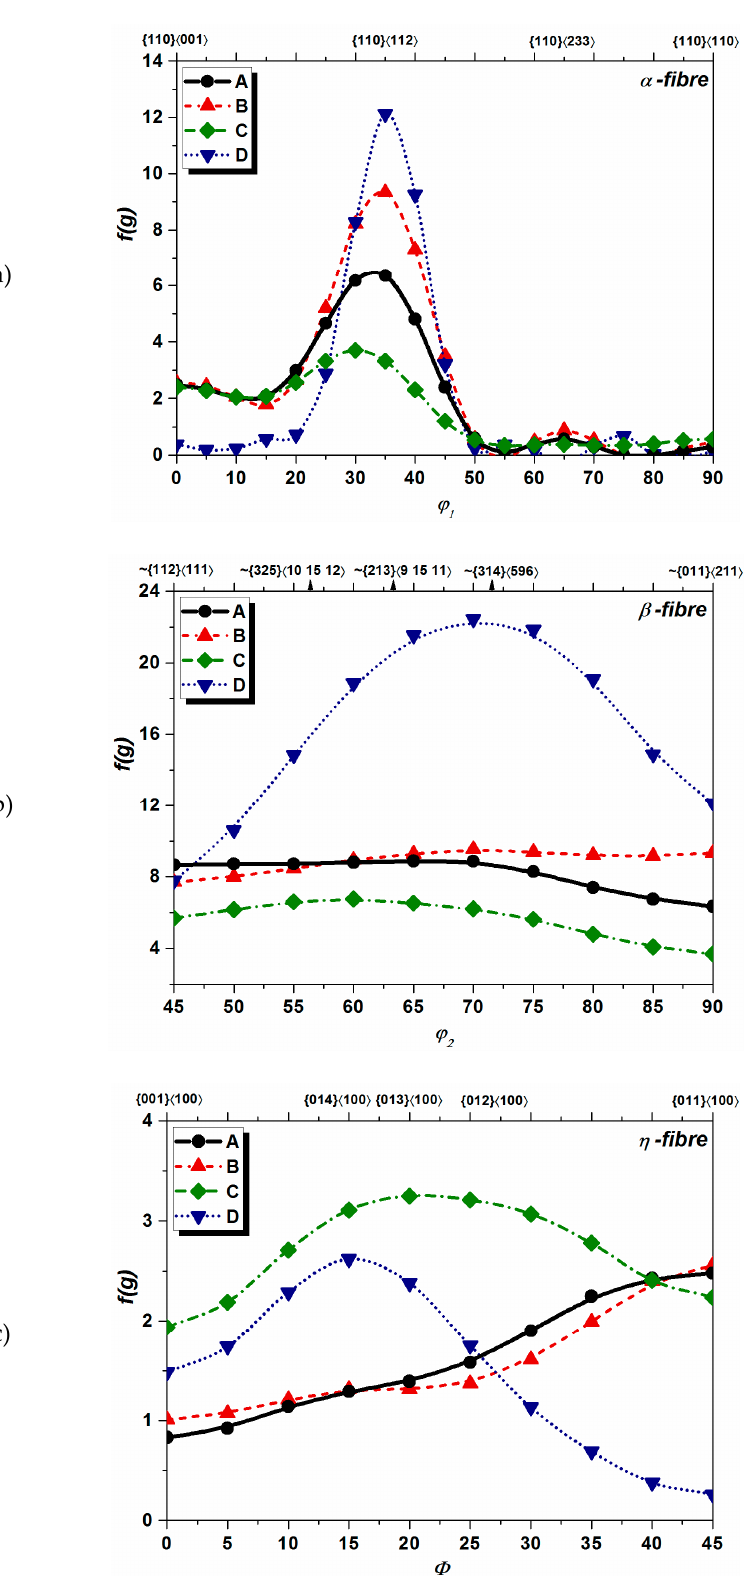
Figure 4. Distribution of orientations along the main texture fibres after 86% thickness reduction: ( a ) α -fibre {011}//ND; ( b ) β -fibre; ( c ) η -fibre {001}//RD.